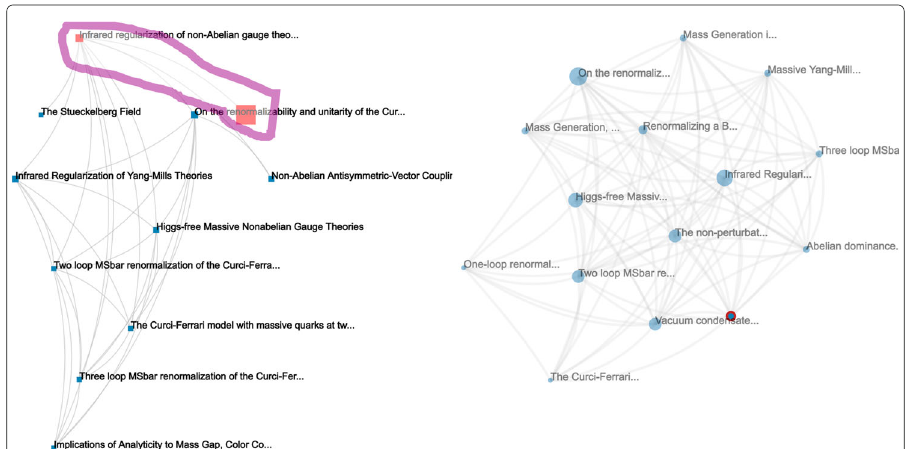
Fig. 18 Detangler (Renoust et al. 2015) view of the subgraph induced by ID9509084 (selective flow). On the left the citation network (size is the selective flow), on the right the layer network (size is the